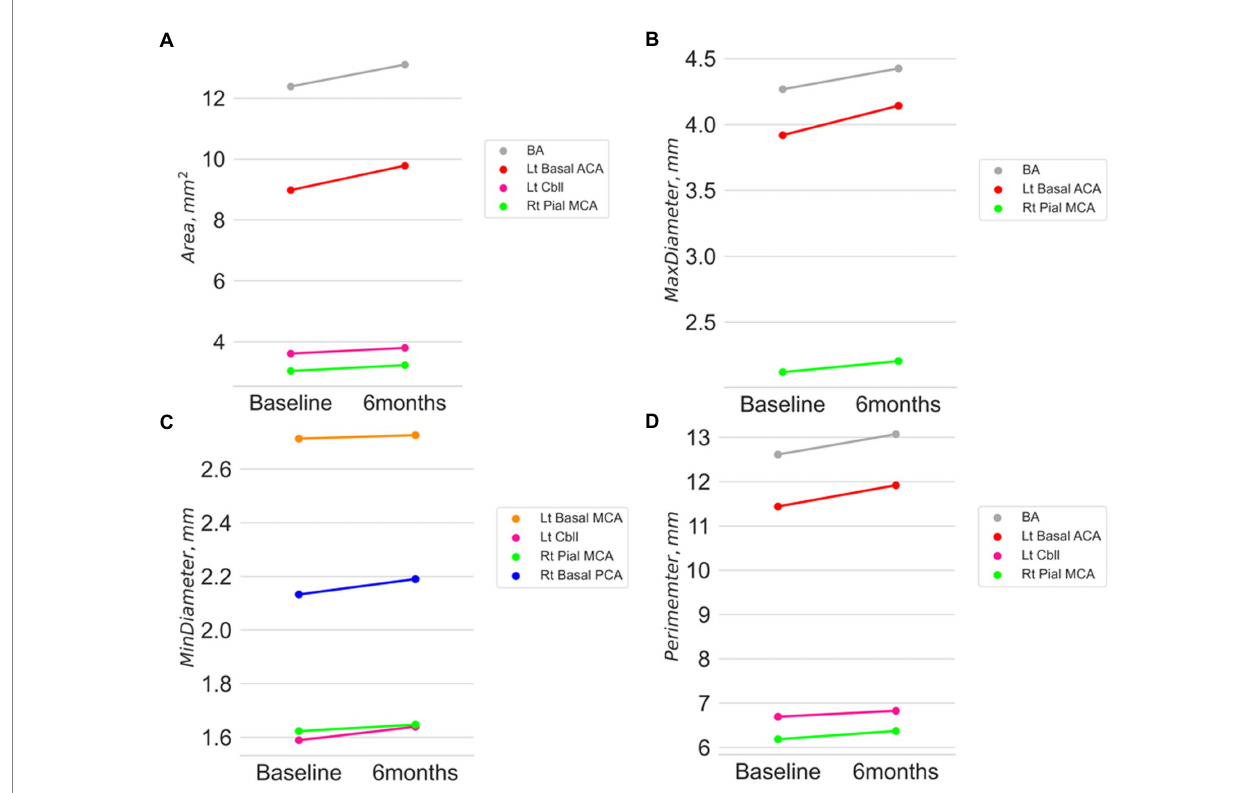
FIGURE 2 Absolute changes of arterial luminal area (A) , the maximum diameter (B) , the mini diameter (C) , and the perimeter (D) after 6 months of intensive statin therapy.